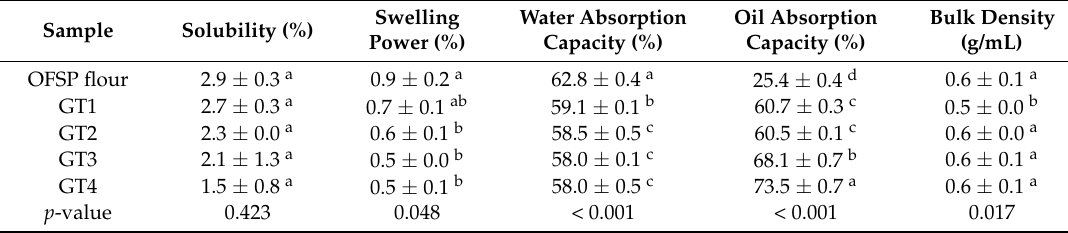
Table 6. Physico-chemical and functional properties (%) of orange fleshed sweet potato-based composite flours on dry weight